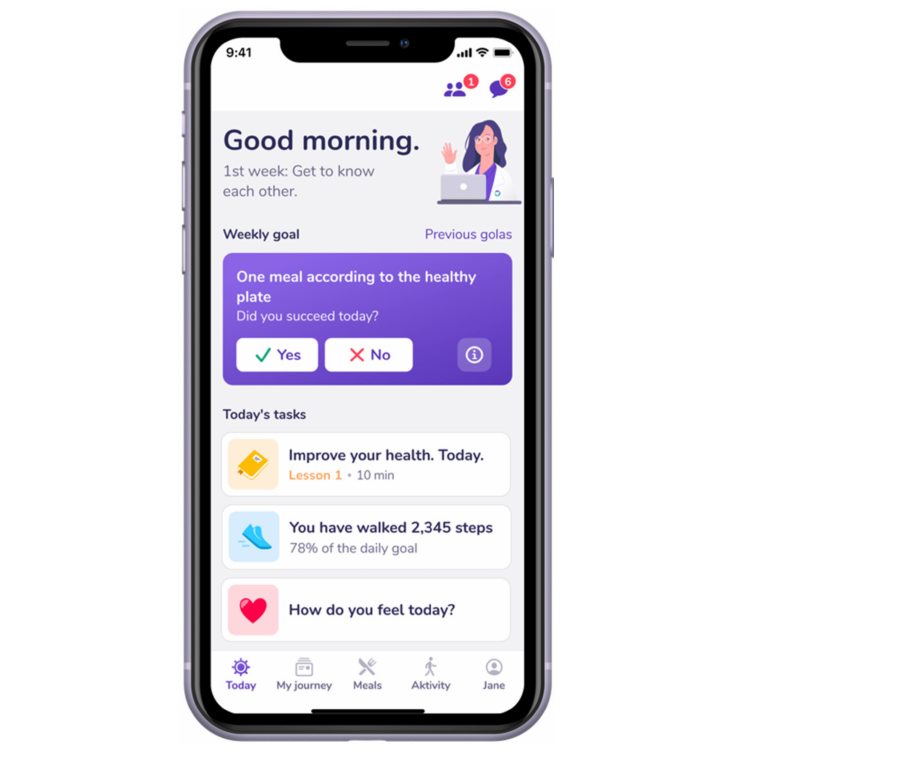
Figure A2. In-app home screen with daily tasks and personal goals.